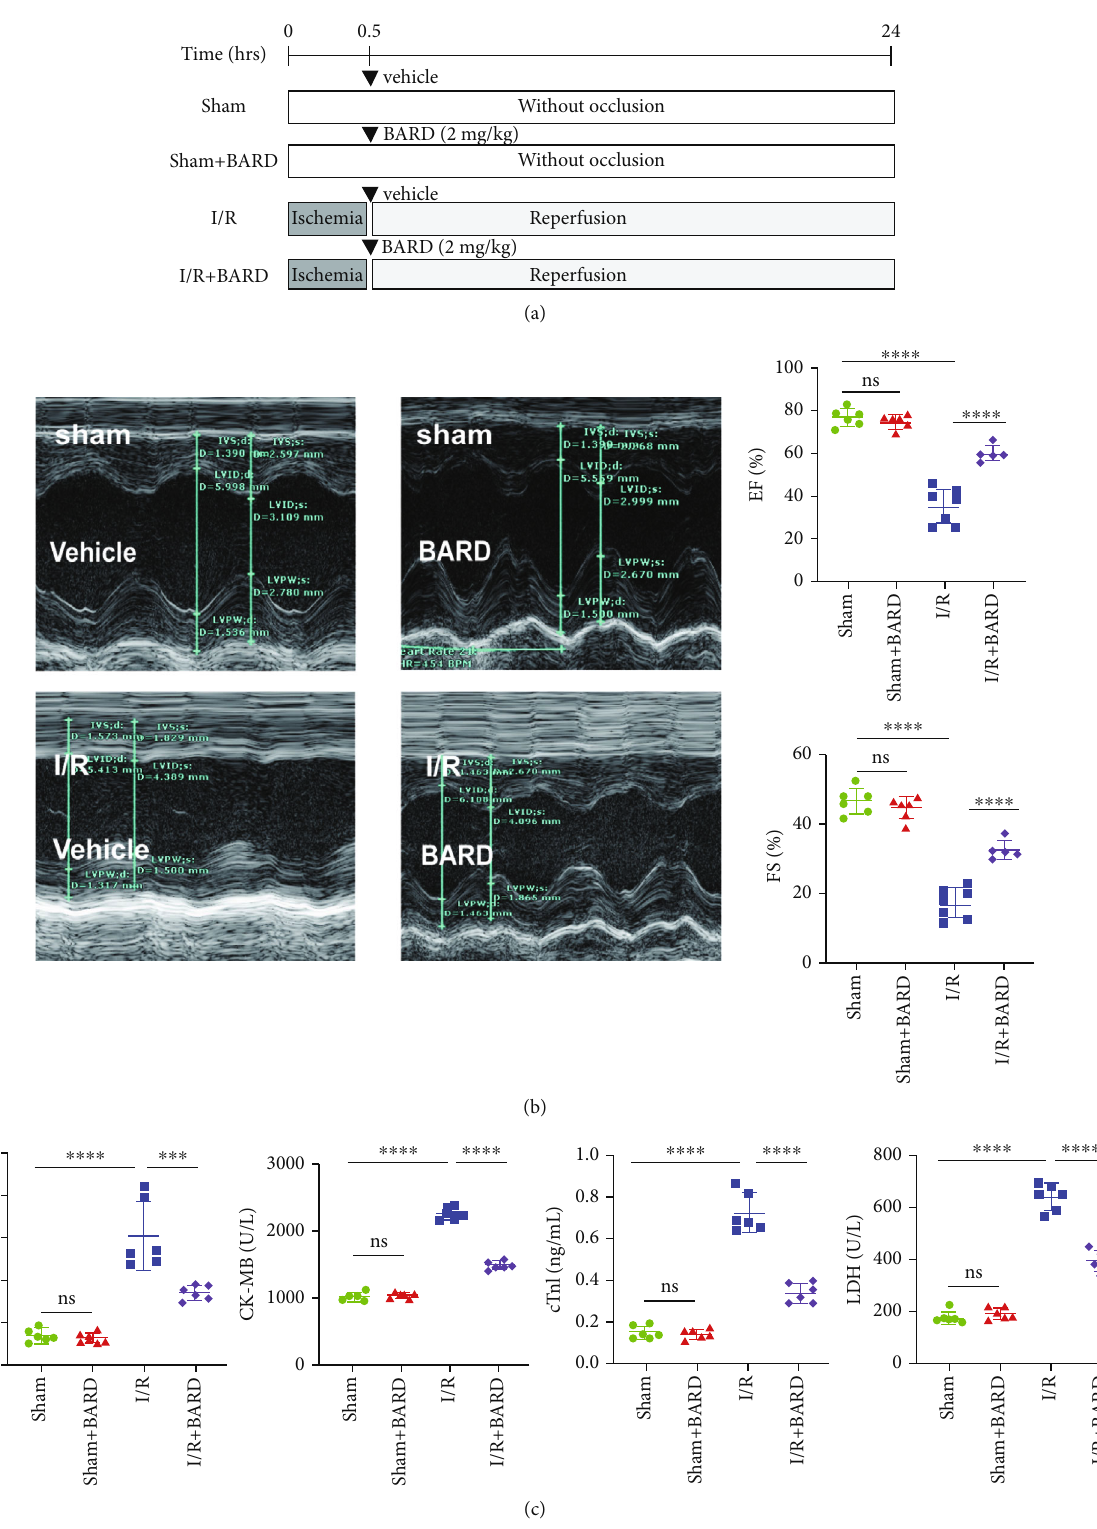
Figure 1: Bardoxolone methyl relieves myocardial I/R-induced cardiac impairment. (a) A scheme showing the timeline of surgical intervention and drug treatment in myocardial I/R rats. (b) Echocardiography was performed to examine the e ff ects of BARD treatments on cardiac functions ( n = 5 − 7 ). (c) Myocardial I/R injury serum markers ( n = 6 ). ∗∗∗ P < 0 : 001 and ∗∗∗∗ P < 0 : 0001 . ns: not signi fi